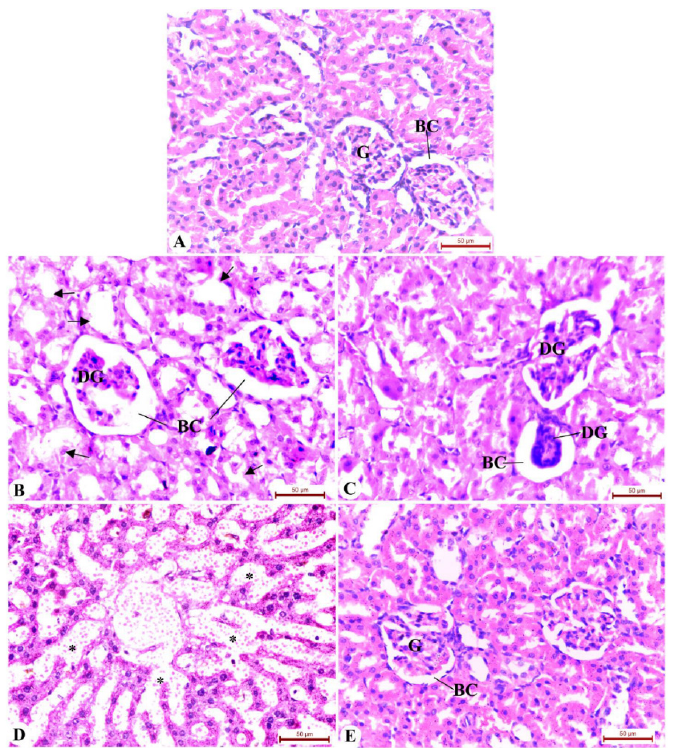
Figure 1. Photomicrographs of kidney of the control and treated groups stained by hematoxylin and eosin. ( A ) Kidney section of control rats showing normal glomeruli (G), Bowman’s space (BC) and normal tubules; (( B )–( D )) CDDP group showing severe glomerular degeneration (DG), dilatation in Bowman’s space, and degeneration in tubular cells (arrow) in kidney, tubular necrosis invaded by inflammatory cells (*); ( E ) Kidney of post-treatment with the OMEE showing normal renal corpuscle and renal tubule more or less like a normal structure with the regeneration of some renal